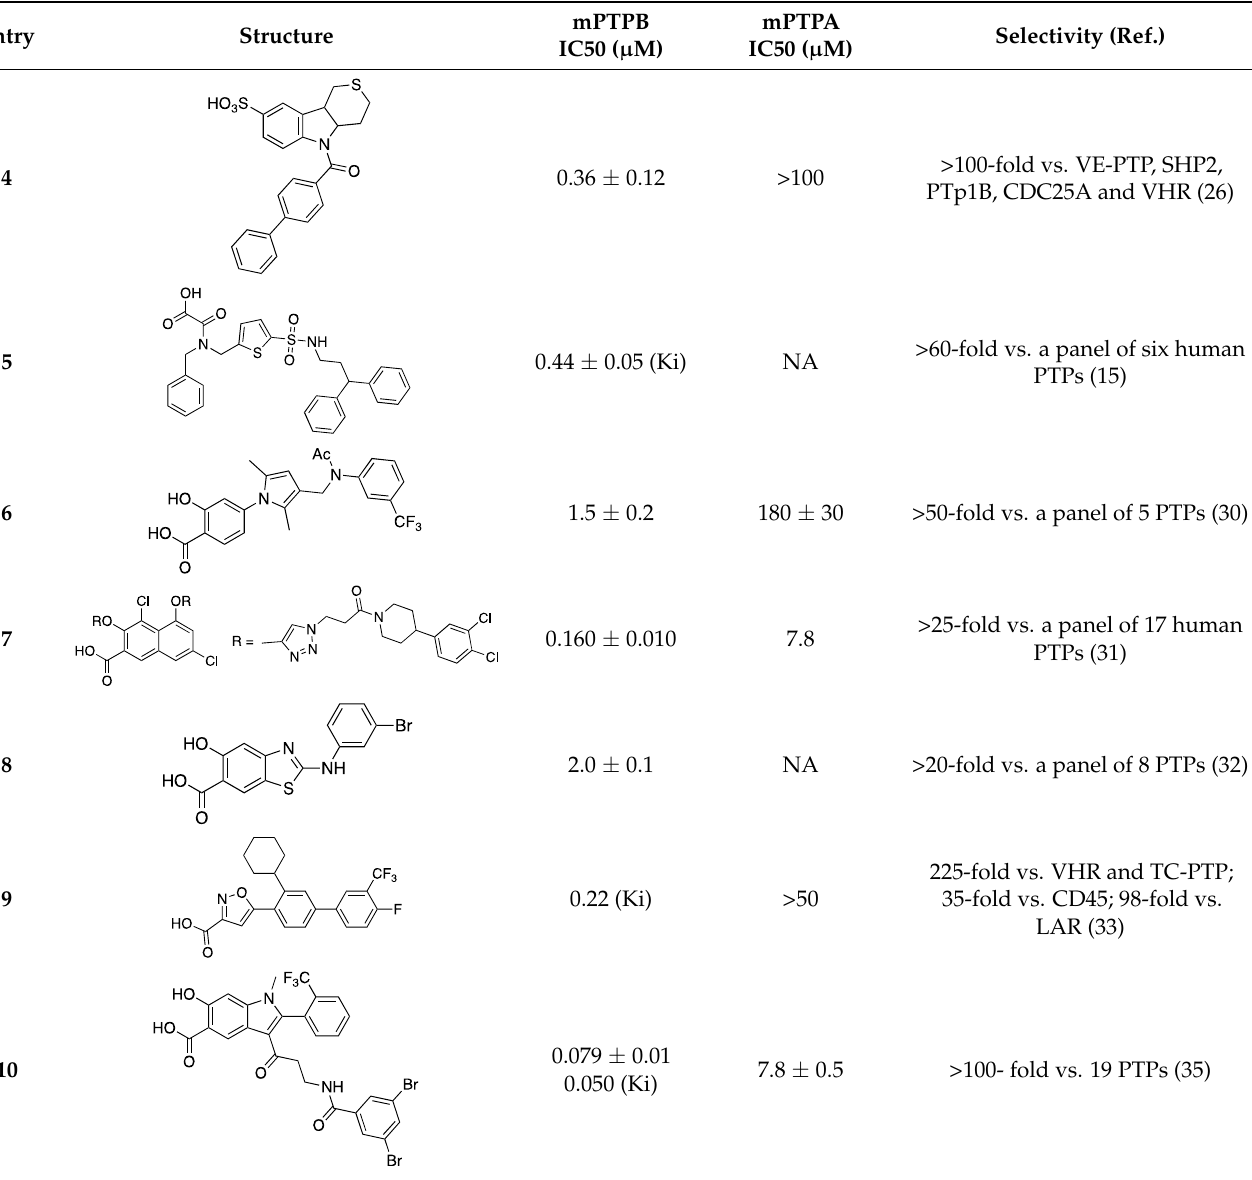
Table 3. Chemical structures and IC 50 values of various mPTPB inhibitors.